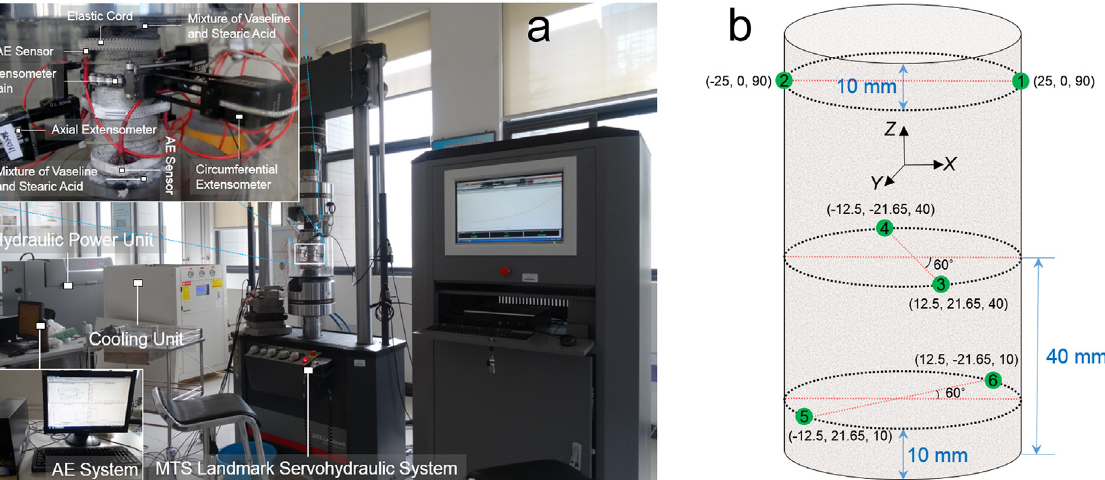
Fig 3. Layout of the testing apparatuses and AE sensors around the specimens. (a) Layout of the extensometers around the specimens (top left view), compression system, and AE system (bottom left view). (b) Location parameters for the acoustic sensors around a specimen, in which the green dots represent AE sensors. The sensors were fixed by elastic cords, as shown in the top left view in Fig 3(a).